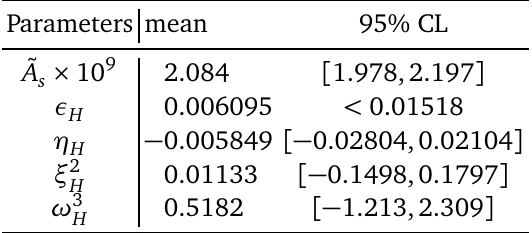
Table 1: Mean values and error bars (95% CL) for the slow-roll parameters shown in Fig